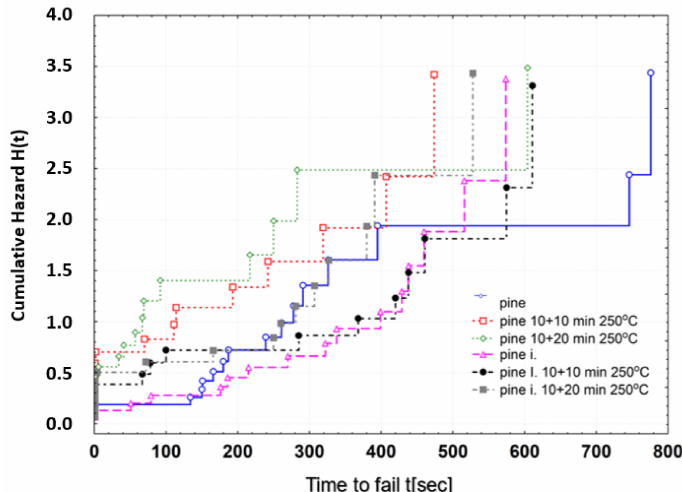
Figure 5. Distribution of risk (cumulative intensity of destruction probability) as a function of time until